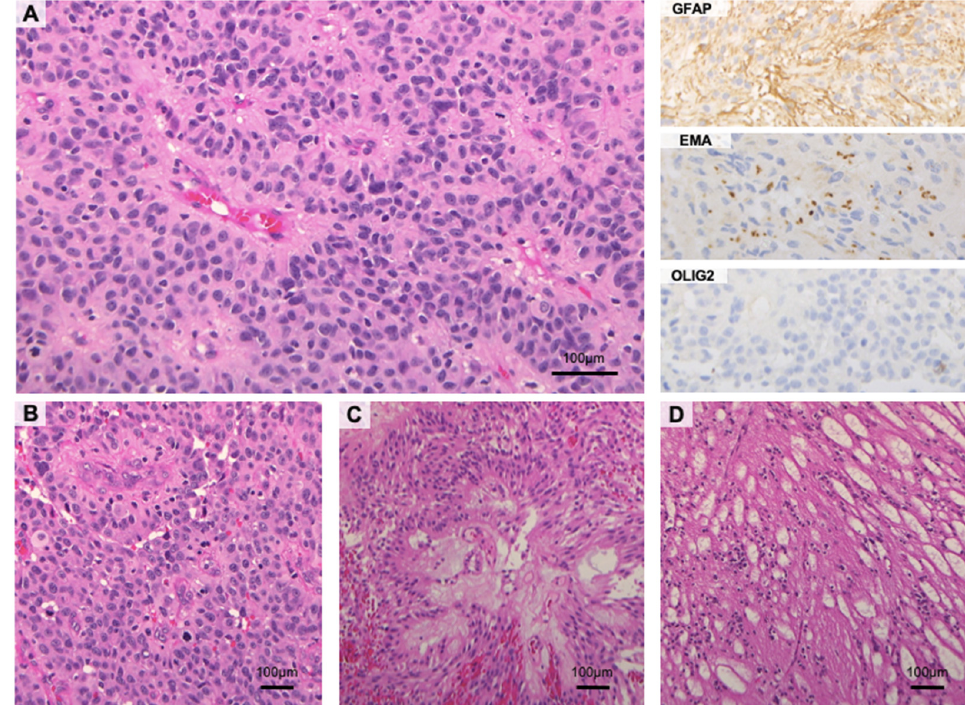
Figure 1. Histological features of ependymal tumors. ( A ) Classic ependymomas are well- circumscribed neoplasms with clear-cut vascular pseudorosettes. Immunohistochemically, the neoplastic cells show variable expression for GFAP with characteristic para-nuclear dot-like positivity for EMA. OLIG2 is weak to negative ( B ) Anaplastic ependymomas are hypercellular tumors with brisk mitotic activity, frequent micro-vascular proliferation, and palisading necrosis. ( C ) Myxopapillary ependymomas feature well-differentiated cuboidal to elongated tumor cells that are radially oriented around vascularized myxoid cores with a papillary architecture. Endothelial proliferation and cellular atypia are typically absent. ( D ) Subependymomas consist of small clusters of cells with isomorphic nuclei, scattered throughout a finely fibrillary background with microcysts (H and E and immunoperoxidase stains; original magnification, 10 × , 20 × and 40 ×